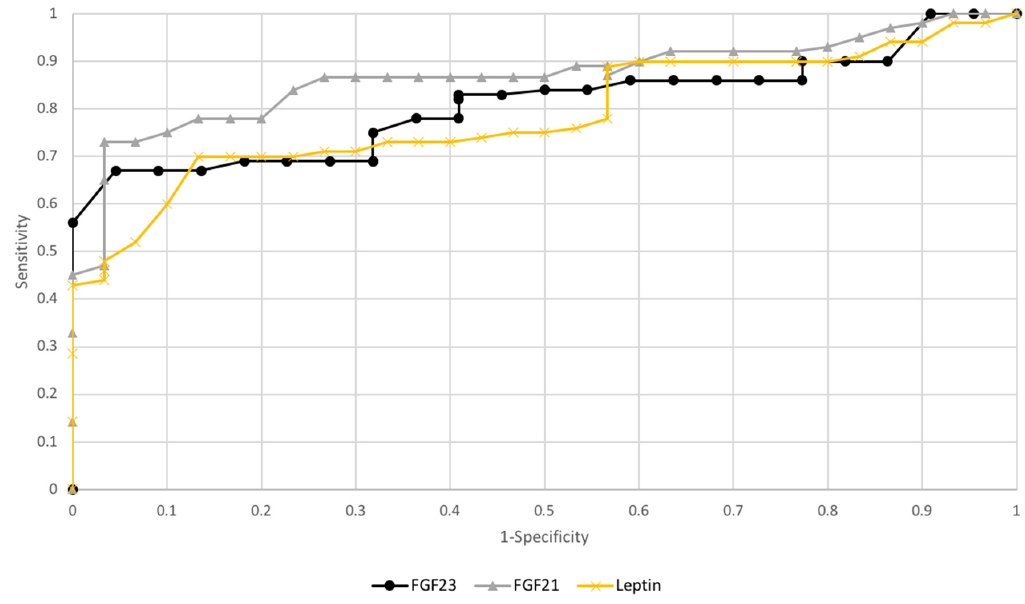
Figure 3. The receiver operating characteristic curves for proteins in endometrial cancer and benign endometrial changes.